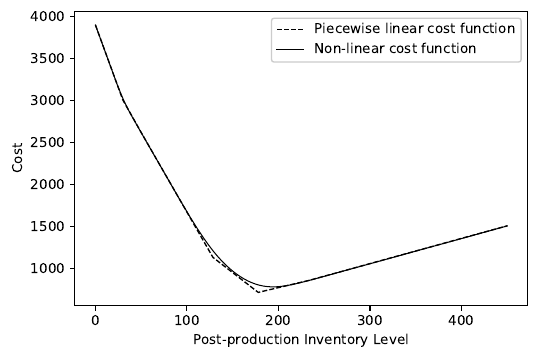
Figure 1. Piecewise linearization of the expected production cycle